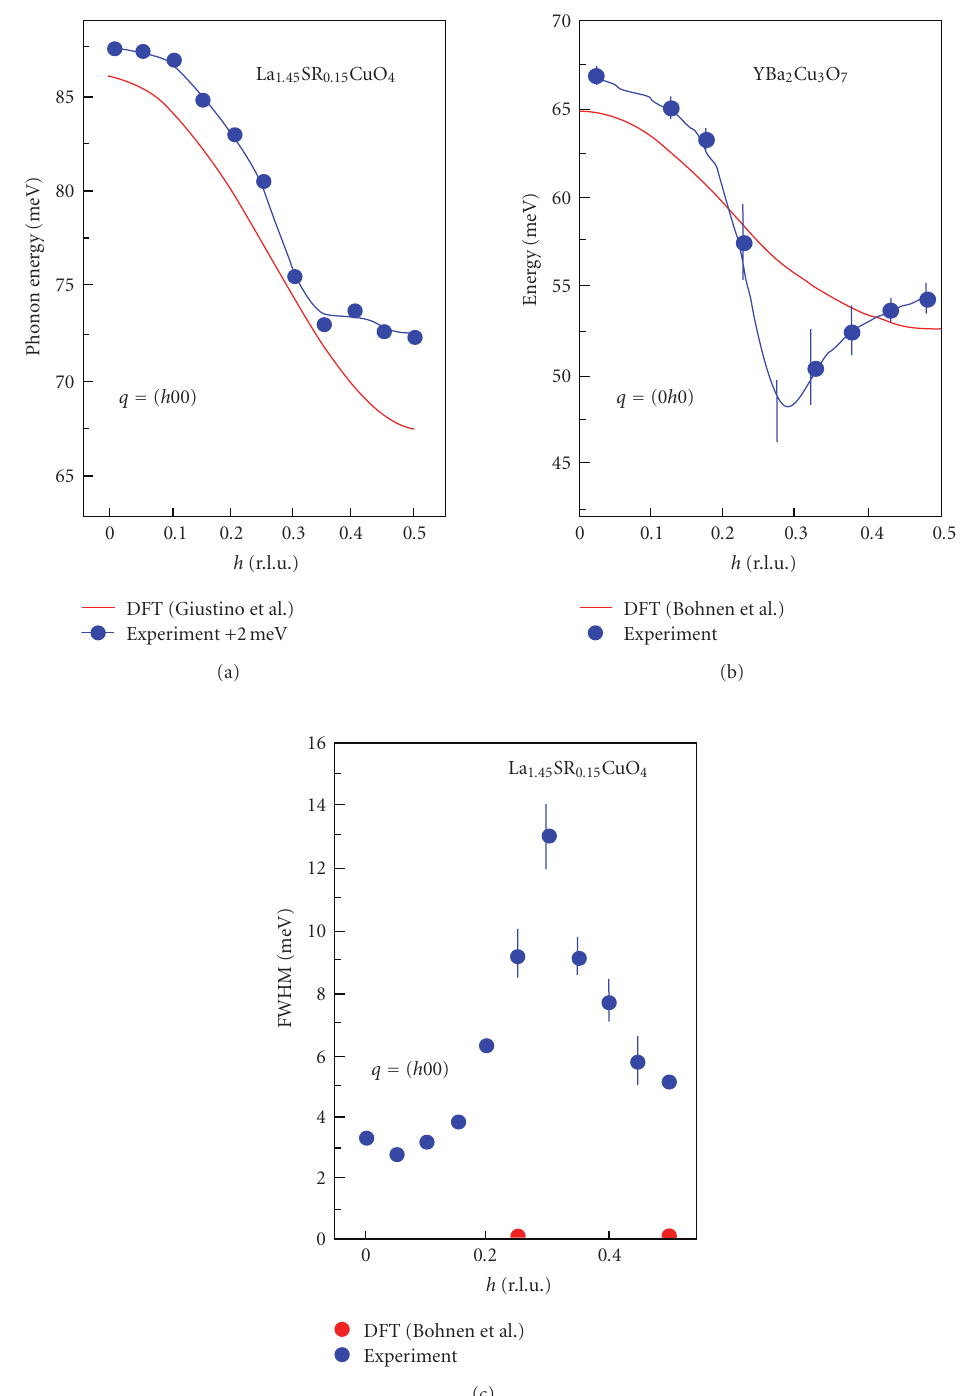
Figure 33: Comparison of DFT calculations with experimental results of inelastic X-ray scattering: (a) phonon energies in La 1 . 85 Sr 0 . 15 CuO 4 and (b) in YBa 2 Cu 3 O 7 ; (c) phonon line-widths in La 1 . 85 Sr 0 . 15 CuO 4 . DFT calculations [28] give much smaller width than experiments [173– 175]. From [178].